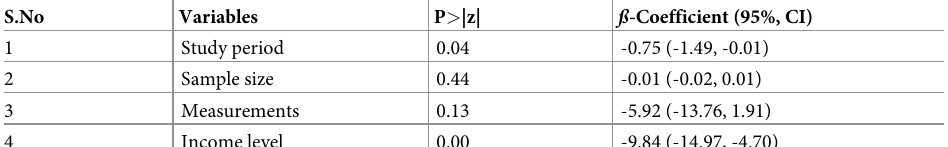
Table 3. Univariate meta-regression analysis result for prevalence of malnutrition among aged population in Africa.